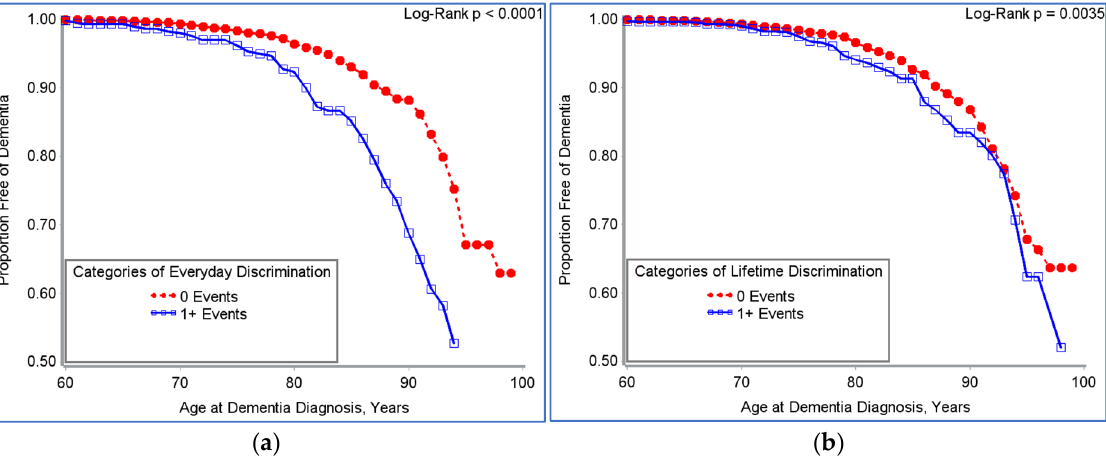
Figure 2. ( a ) Dementia-free survival time by experiences of everyday discrimination among participants in the HRS, 2006–2016; ( b ) dementia-free survival time by major experiences of lifetime discrimination among participants in the HRS, 2006–2016. Table 2. Race, toxic stress, and resilience promoting factors in relation to risk for incident dementia among older adults enrolled in the HRS 2006–2016.